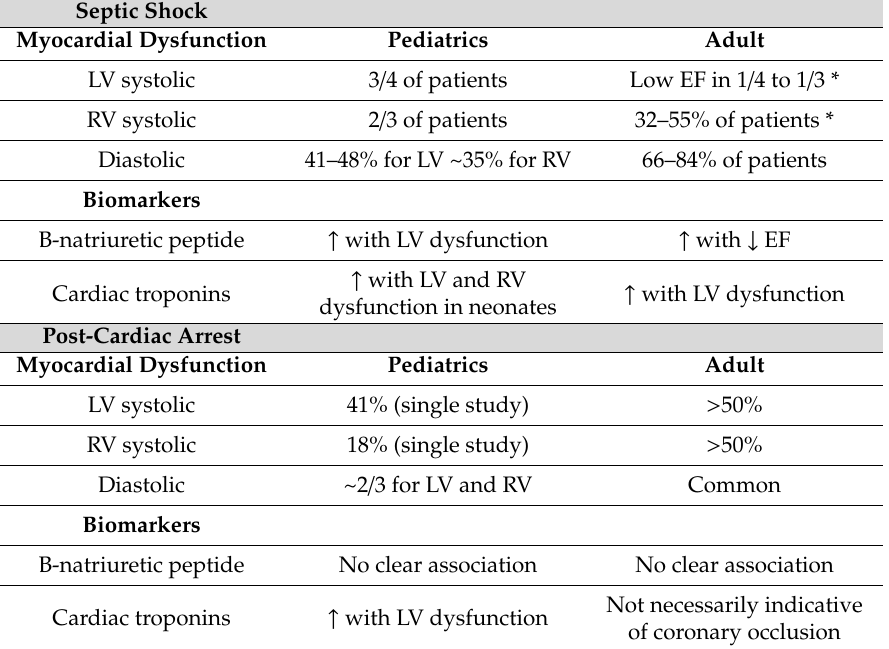
Table 1. Characteristics of myocardial dysfunction in septic shock and post-cardiac